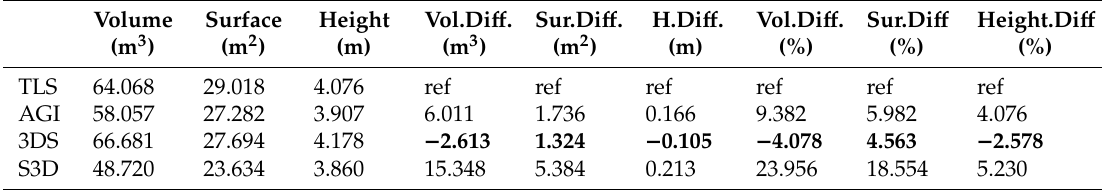
Table 8. Boulder No. 2: volume, surface area and height and particular model di ff erences.